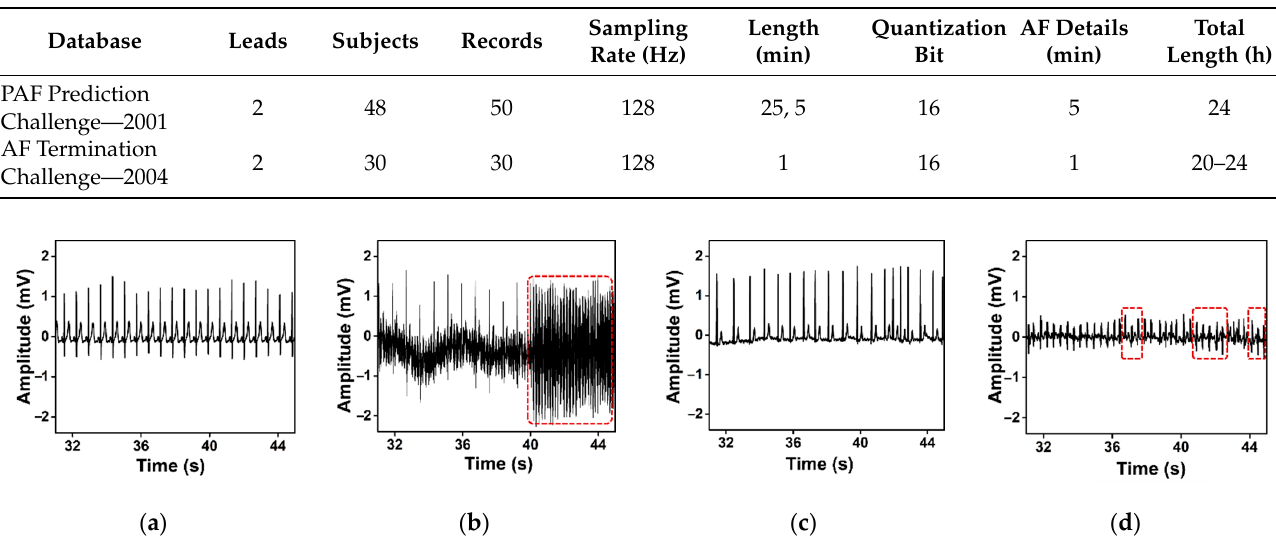
Table 3. Description of database in use.